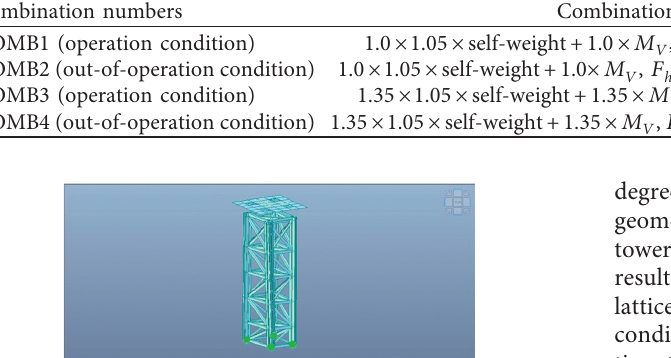
Figure 4: The finite element model.